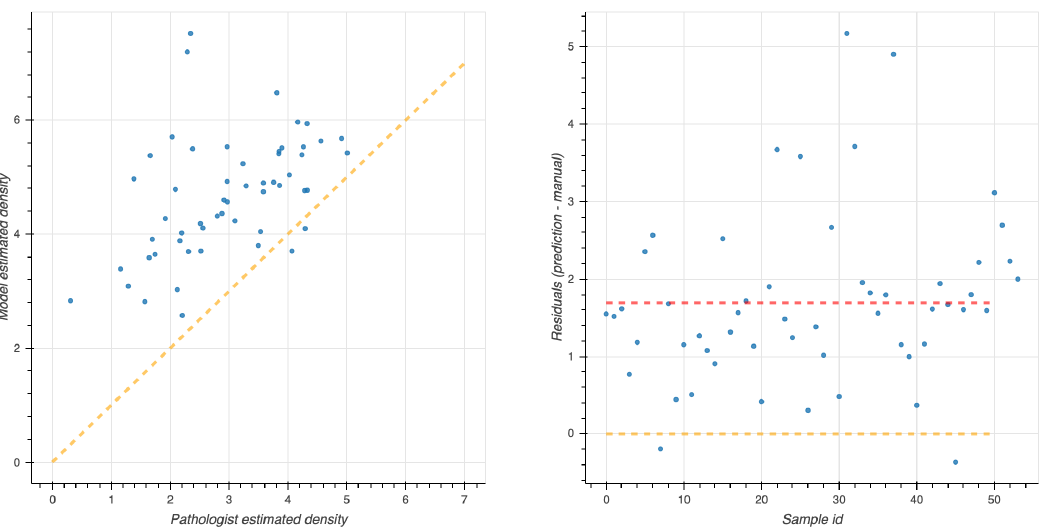
Figure 7. Comparison between DL and human expert density estimations computed for the 54 patients of the NeSTBG dataset. Notice that the pathologist estimation is computed on 10 regions of interest while the DL predicted densities are computed on the whole slide. Left panel : correlation plot for predicted densities and density estimated by pathologists. Right panel : residual plot for difference between DL and pathologist density estimation. Yellow line, both panels: perfect correlation. Red line: average difference between DL and pathologist